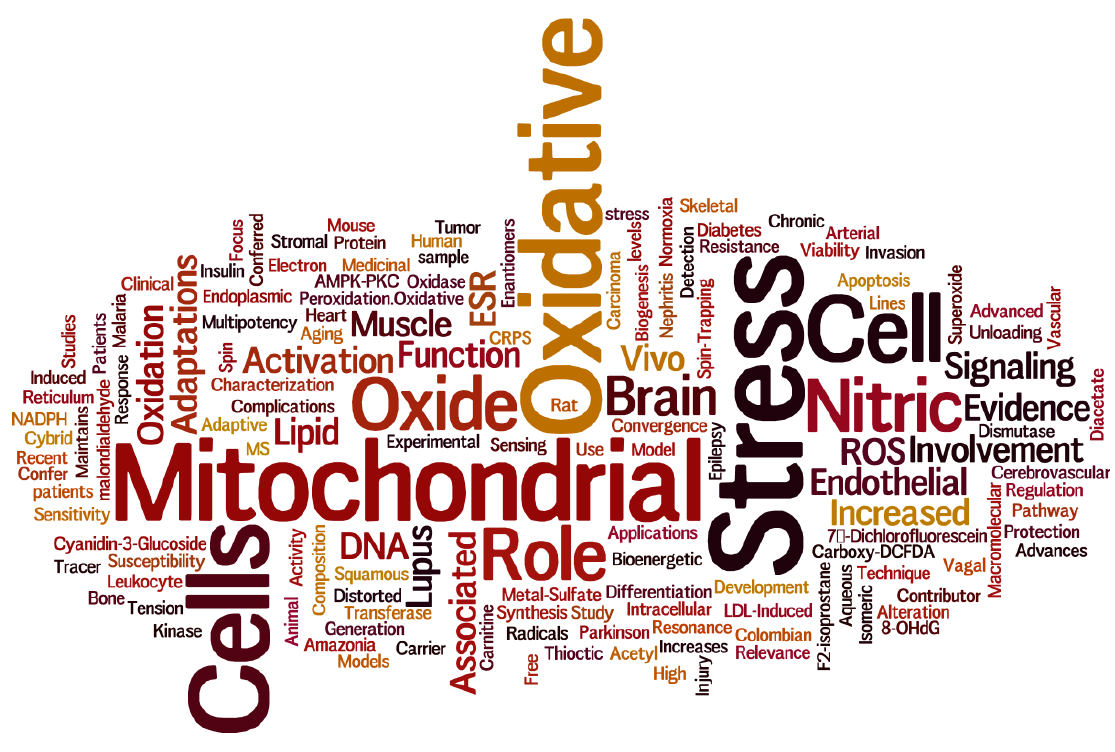
Figure 1. A word cloud created using the titles of all 24 peer-reviewed articles in this special issue. The relative size of each word is weighted according to the frequency with which it is used among all